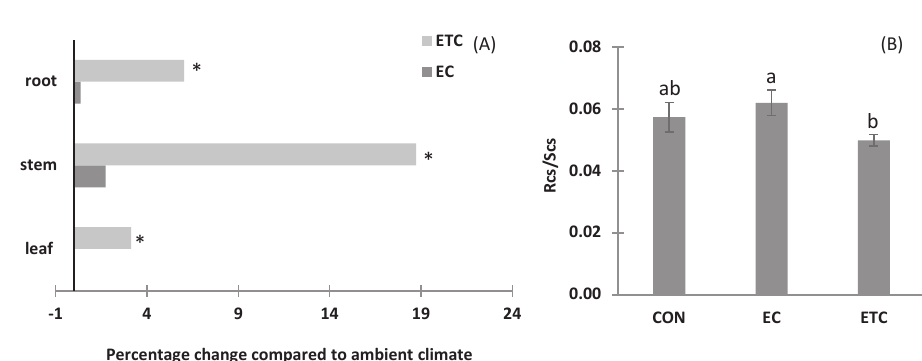
Fig. 2. A. Change of carbon content in different plant parts (%) under changed climate conditions compared with ambient climate. (* - statistically significant difference, compared to ambient climate conditions at P < 0.05). B. The ratio of root carbon stock (Rcs) and shoot carbon stock (Scs) under different climate conditions. Different letters indicate significant differences among treatments ( p <0.05) based on U-test.